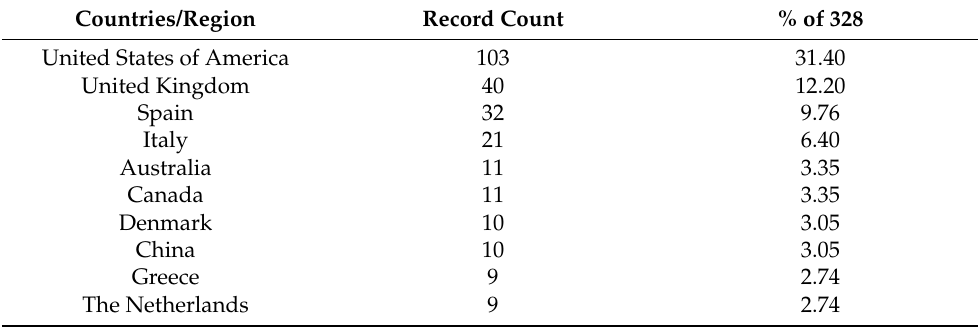
Table 4. Countries represented in affiliations in the bibliographic study.